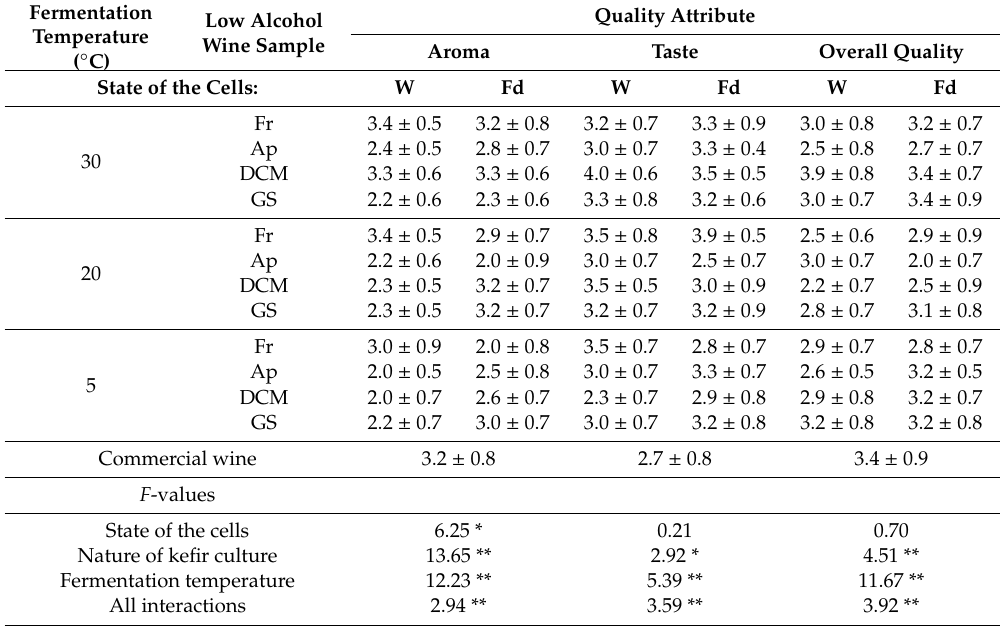
Table S1: Minor volatile compounds (mg / L) identified in low alcohol wines produced by wet or freeze-dried kefir culture at various temperatures (5–30 ◦ C) using the HS-SPME GC / MS analysis. Volatiles were semi-quantified using 4-methyl-2-pentanol as internal